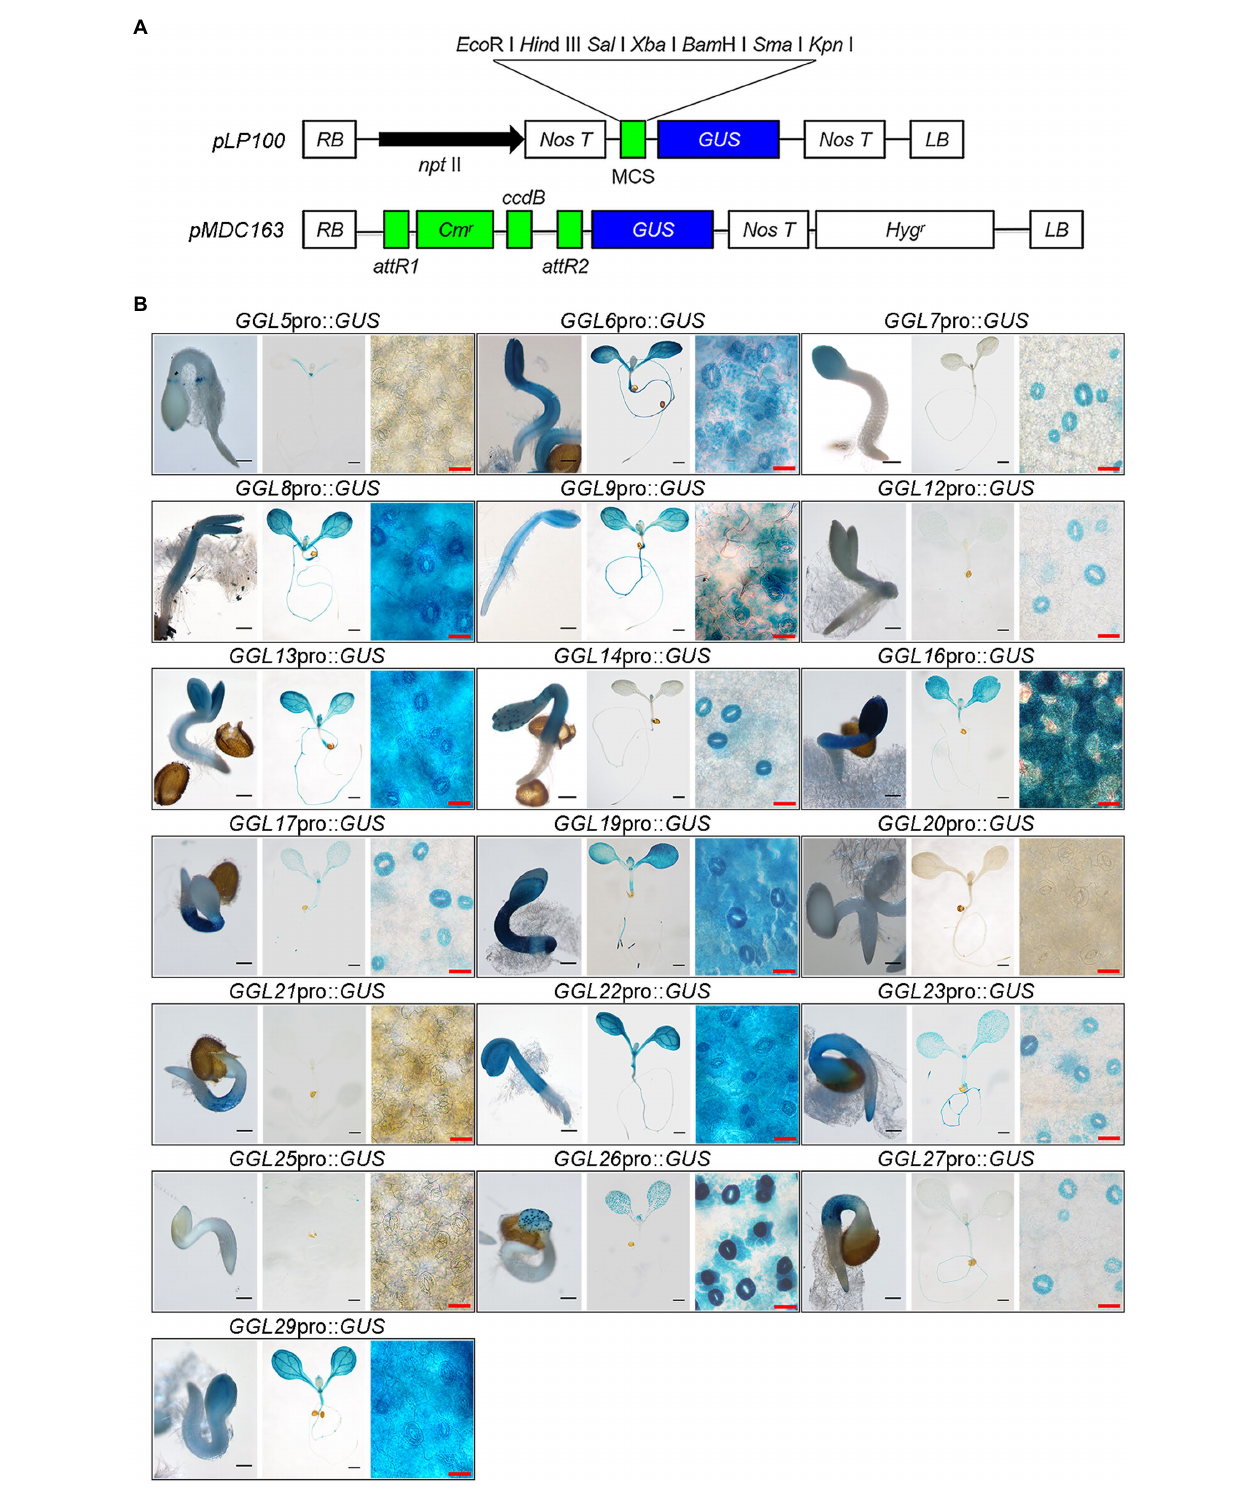
FIGURE 2 | Expression patterns of 19 GGLs at the early seedling stage. (A) Schematic charts of two destination vectors ( pLP100 and pMDC163 ) used for GUS expression driven by GGL native promoters. (B) Expression profile analyses of 19 GGLs at the early seedling stage. GGL pro:: GUS expressing transgenic seedlings that grown in a growth chamber were stained with X-Gluc. For each gene, the images from left to right represent a seedling of 1.5 days after germination (DAG; scale bar = 200 μ m), a seedling of 6 DAG (scale bar = 1 mm), and an enlarged part of the cotyledon from the 6-DAG seedling (scale bar = 25 μ m),